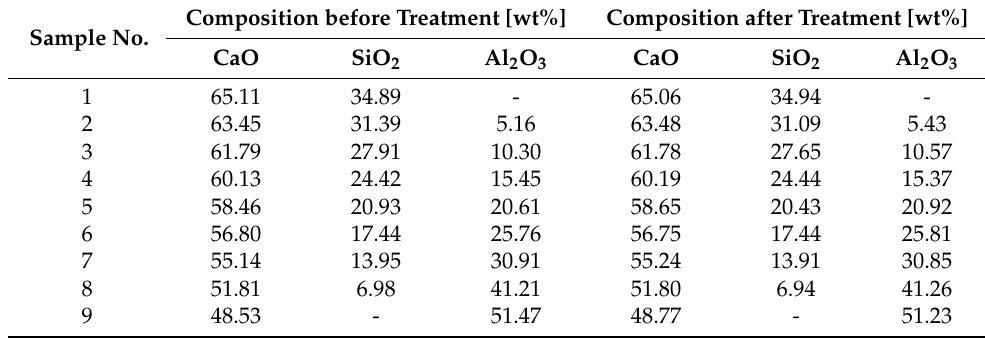
Table 2. Chemical composition of samples before and after thermal